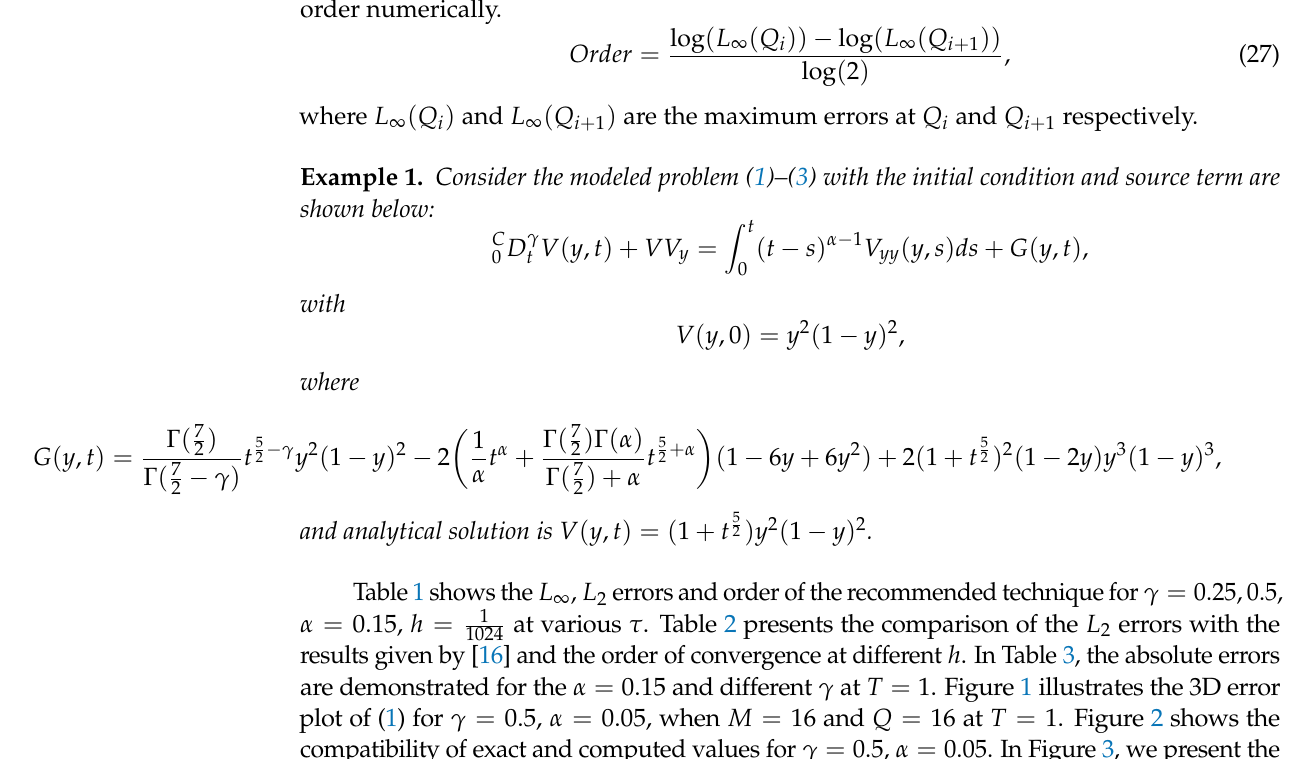
Table 1. The L ∞ , L 2 errors of Example 1 for α = 0.15, h = 1